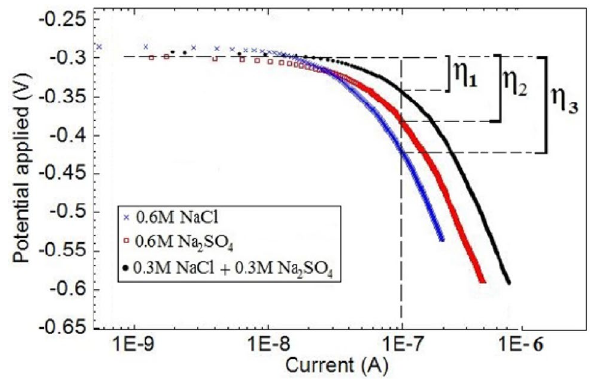
Figure 12. The polarization plots of copper (3.14 mm 2 ) in different solutions at 60 °C.